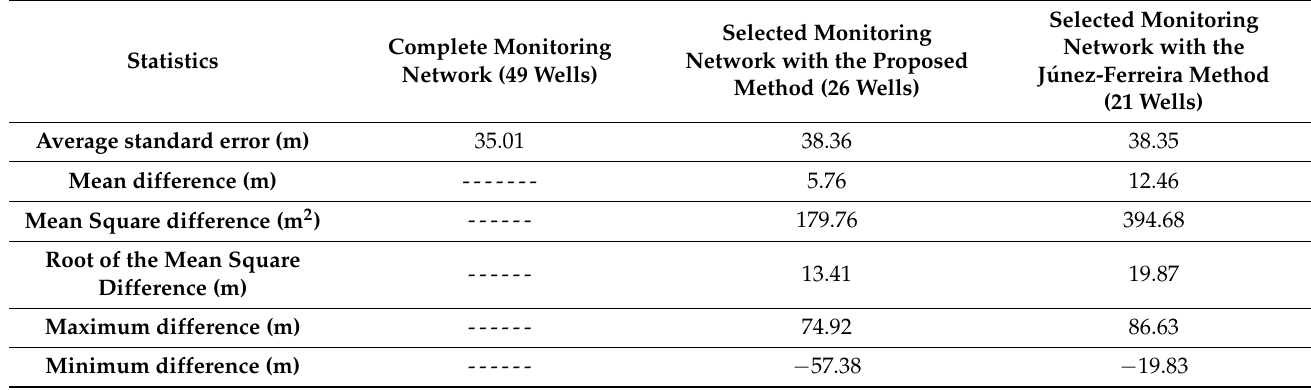
Table 3. Statistics of the groundwater-level estimates in the Calera